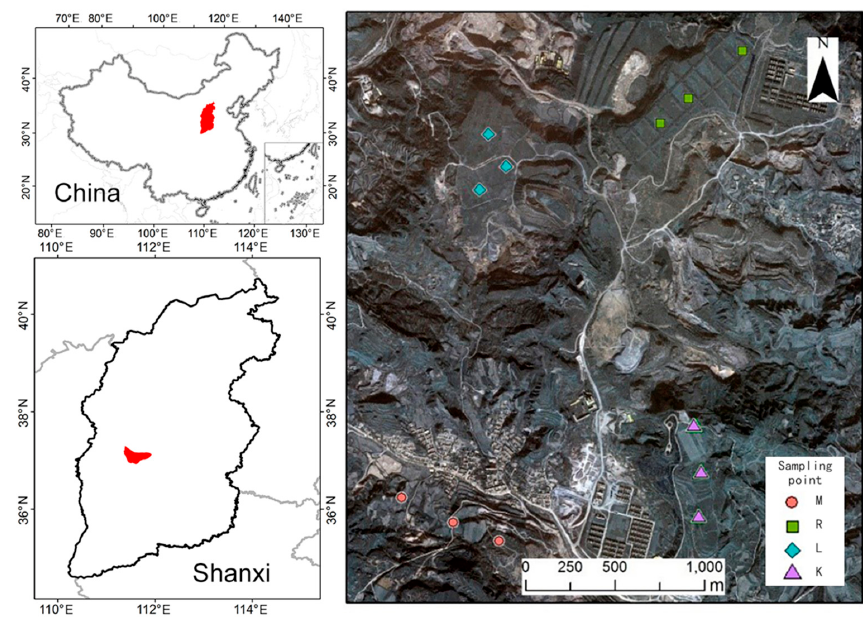
Figure 1. Sampling sites in the study area (M is alfalfa; R is yellow rose; L is lespedeza; K is sweet wormwood herb).